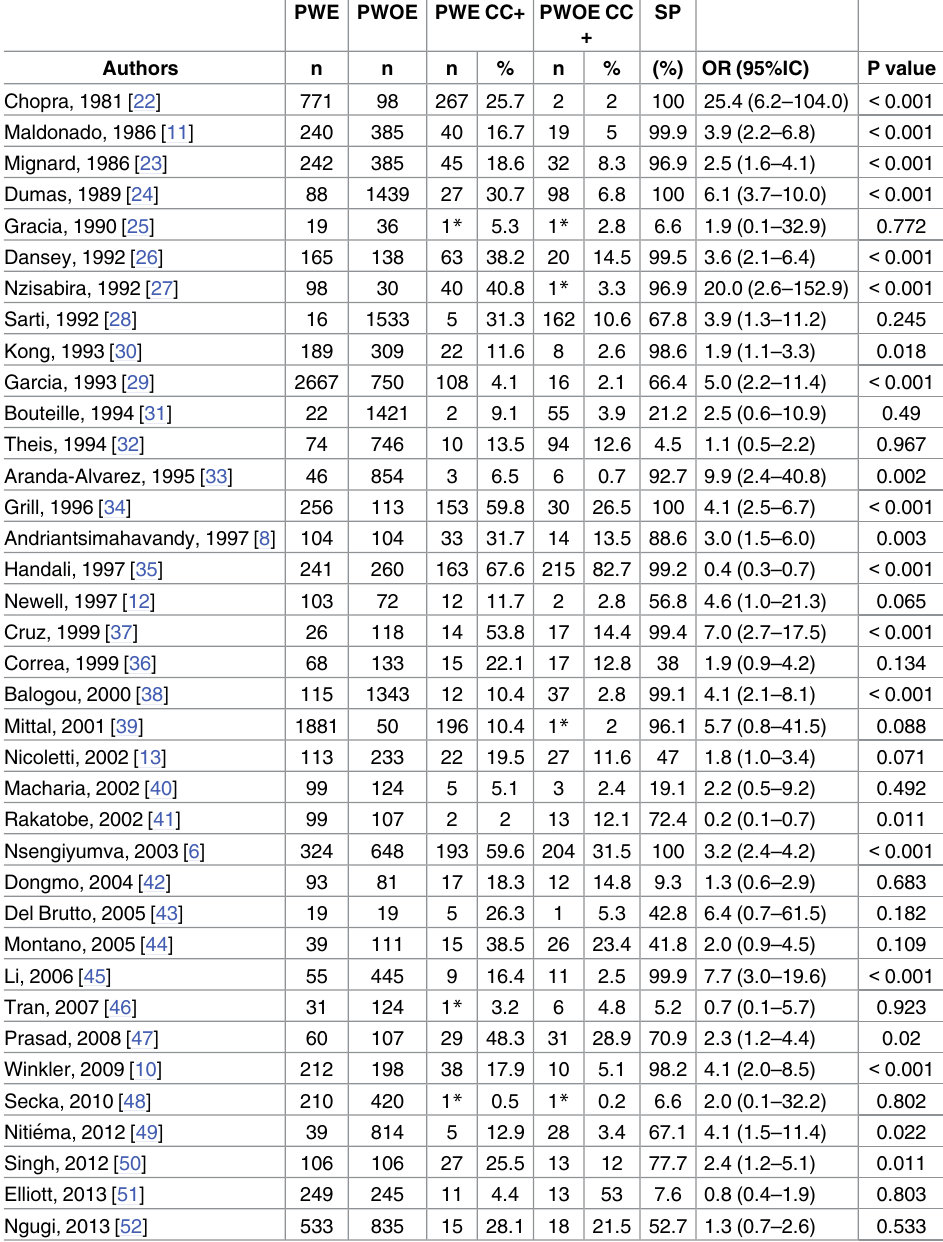
Table 2. Results obtained in studies looking for an association between cysticercosis and epilepsy classified by year of